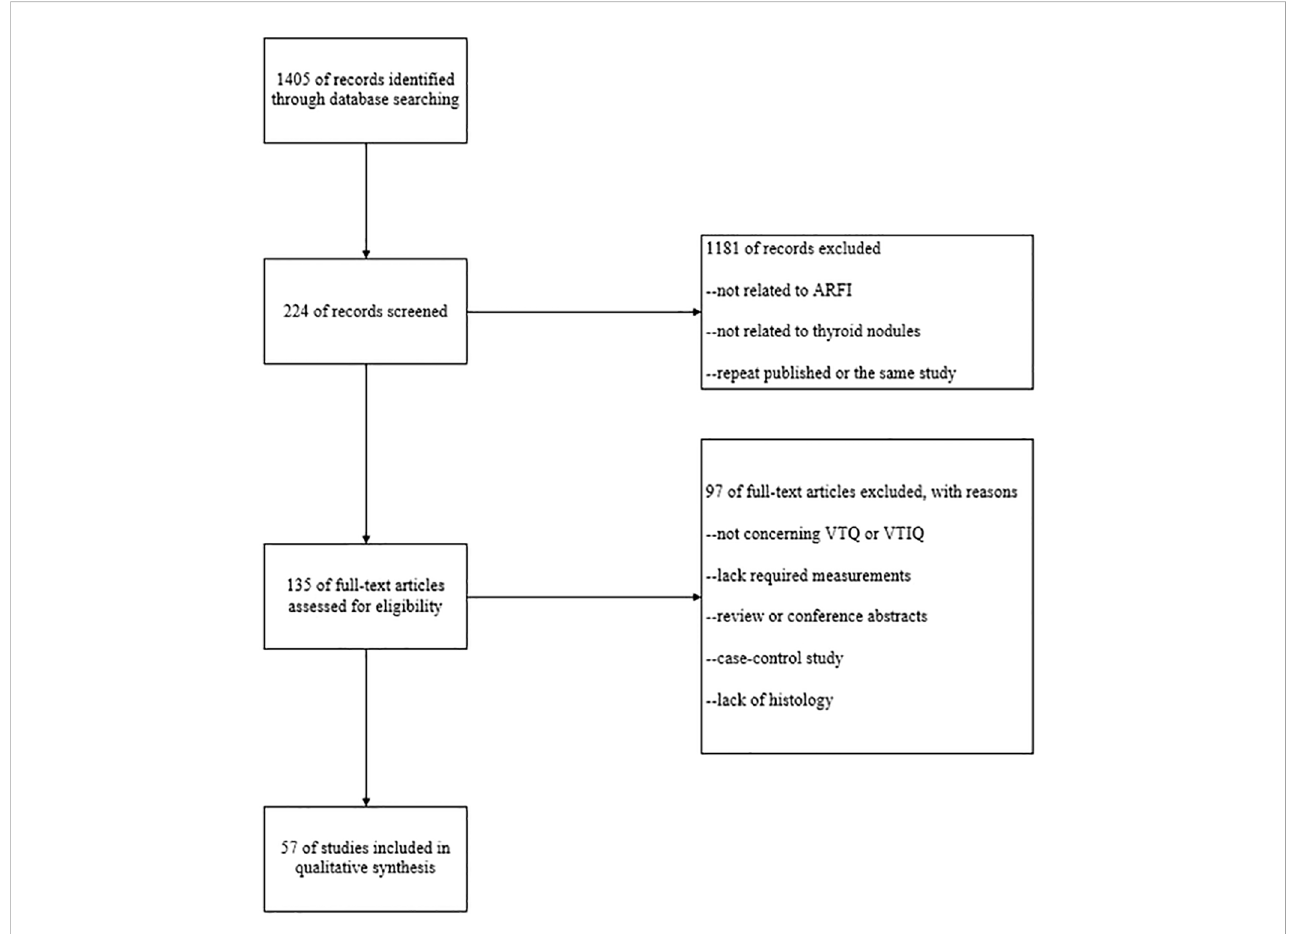
FIGURE 1 Inclusion and exclusion process of the